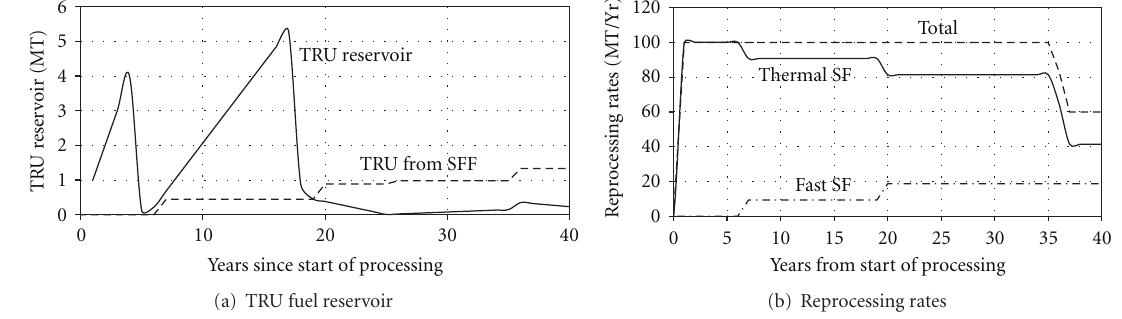
Figure 4: Conversion to two thermal, two fast spectrum plants (BR = 0.5, then to 0.55 and then 0.75).